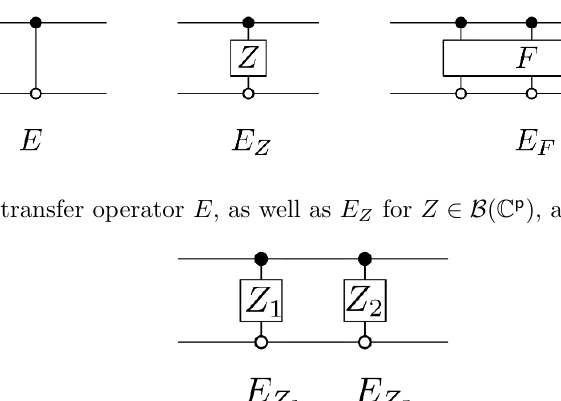
Figure 3 . The product E Z operator corresponds to attaching the corresponding diagram on the